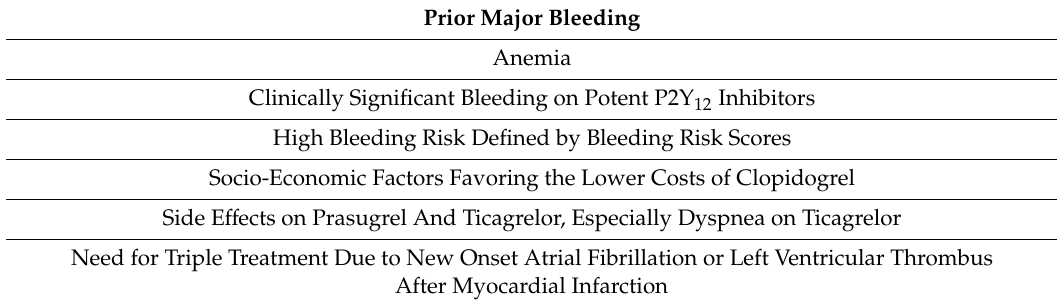
Table 2. Variables that could be considered for favoring de-escalation of dual antiplatelet therapy.